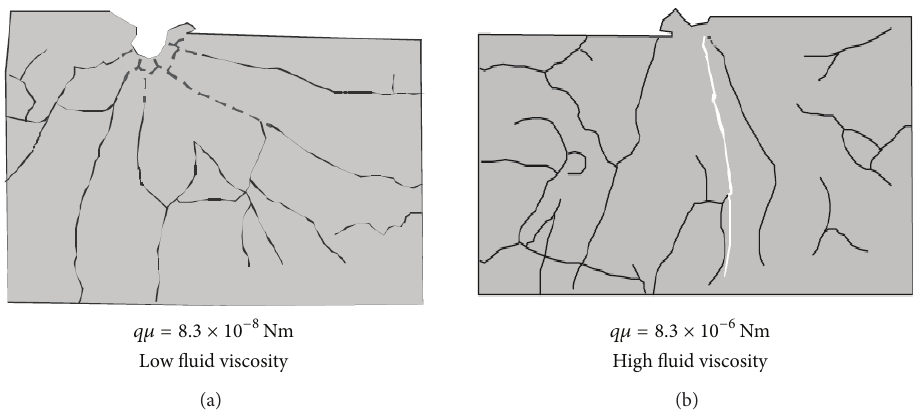
Figure 12: Experimental results contract of fluid viscosity impact on fracture pattern [14].